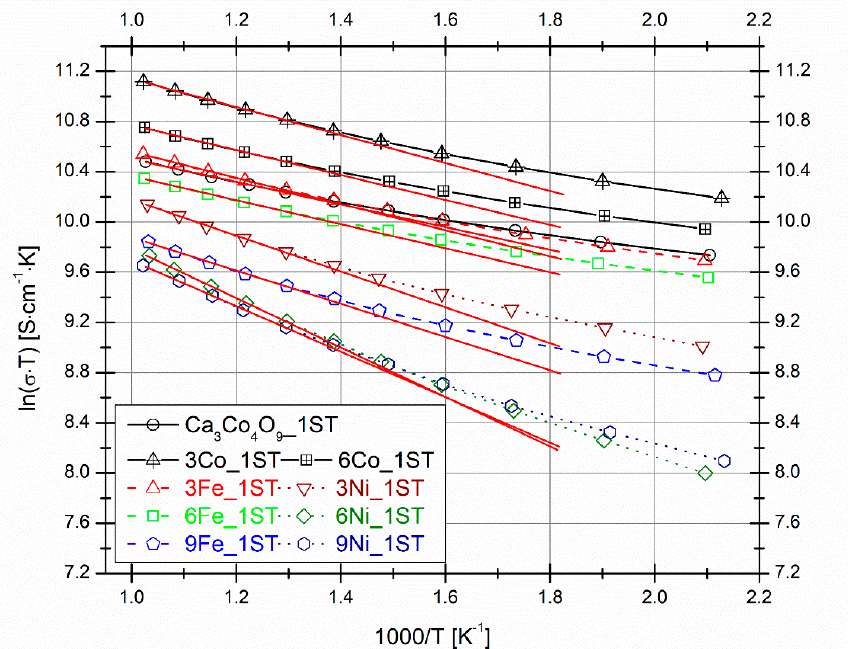
Figure 5. ln( σ ·T) vs. 1000/T (Arrhenius) plots for all 1ST sintered samples. The red lines represent linear fittings at high temperatures for activation energy ( E a ) calculations.